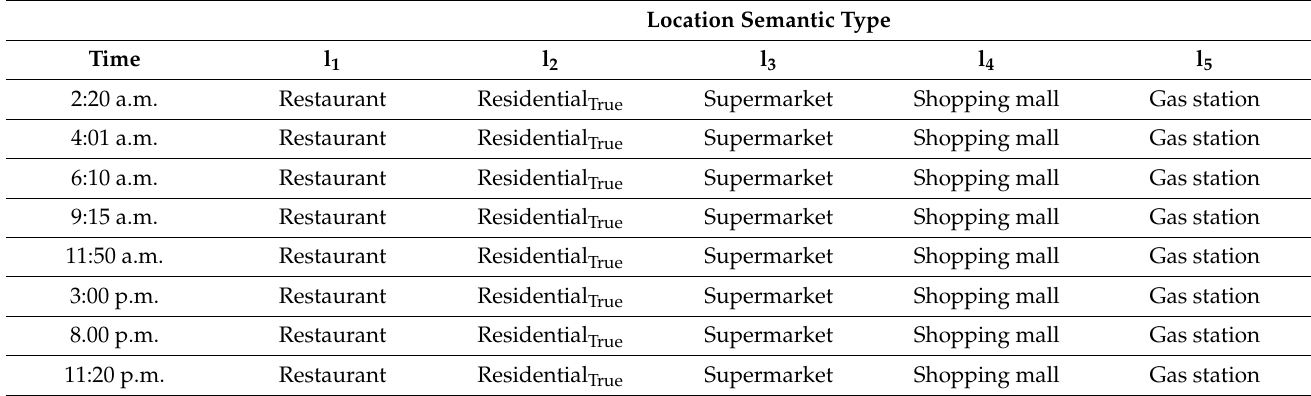
Table 1. Showing the semantic information associated with locations in sample LBS requests. Location Semantic